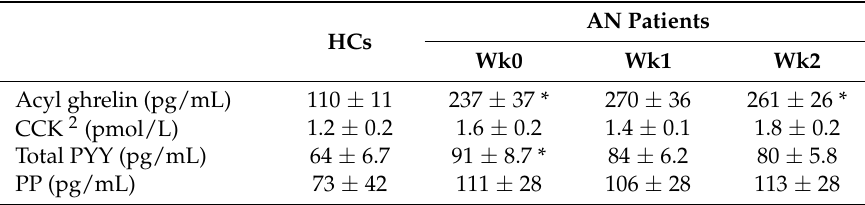
Table 3. Plasma hormone concentrations at baseline 1 .